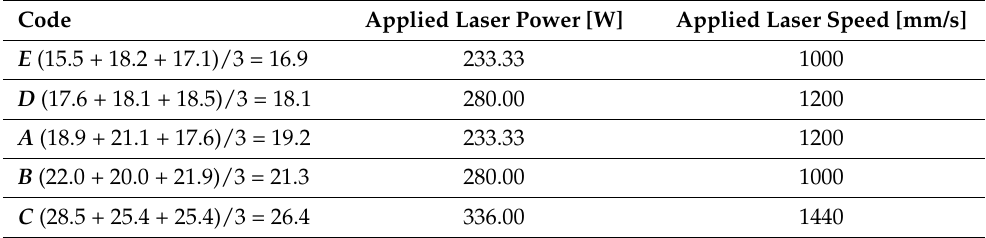
Table 9. Improvement ratio index order for R a , R z , and R q